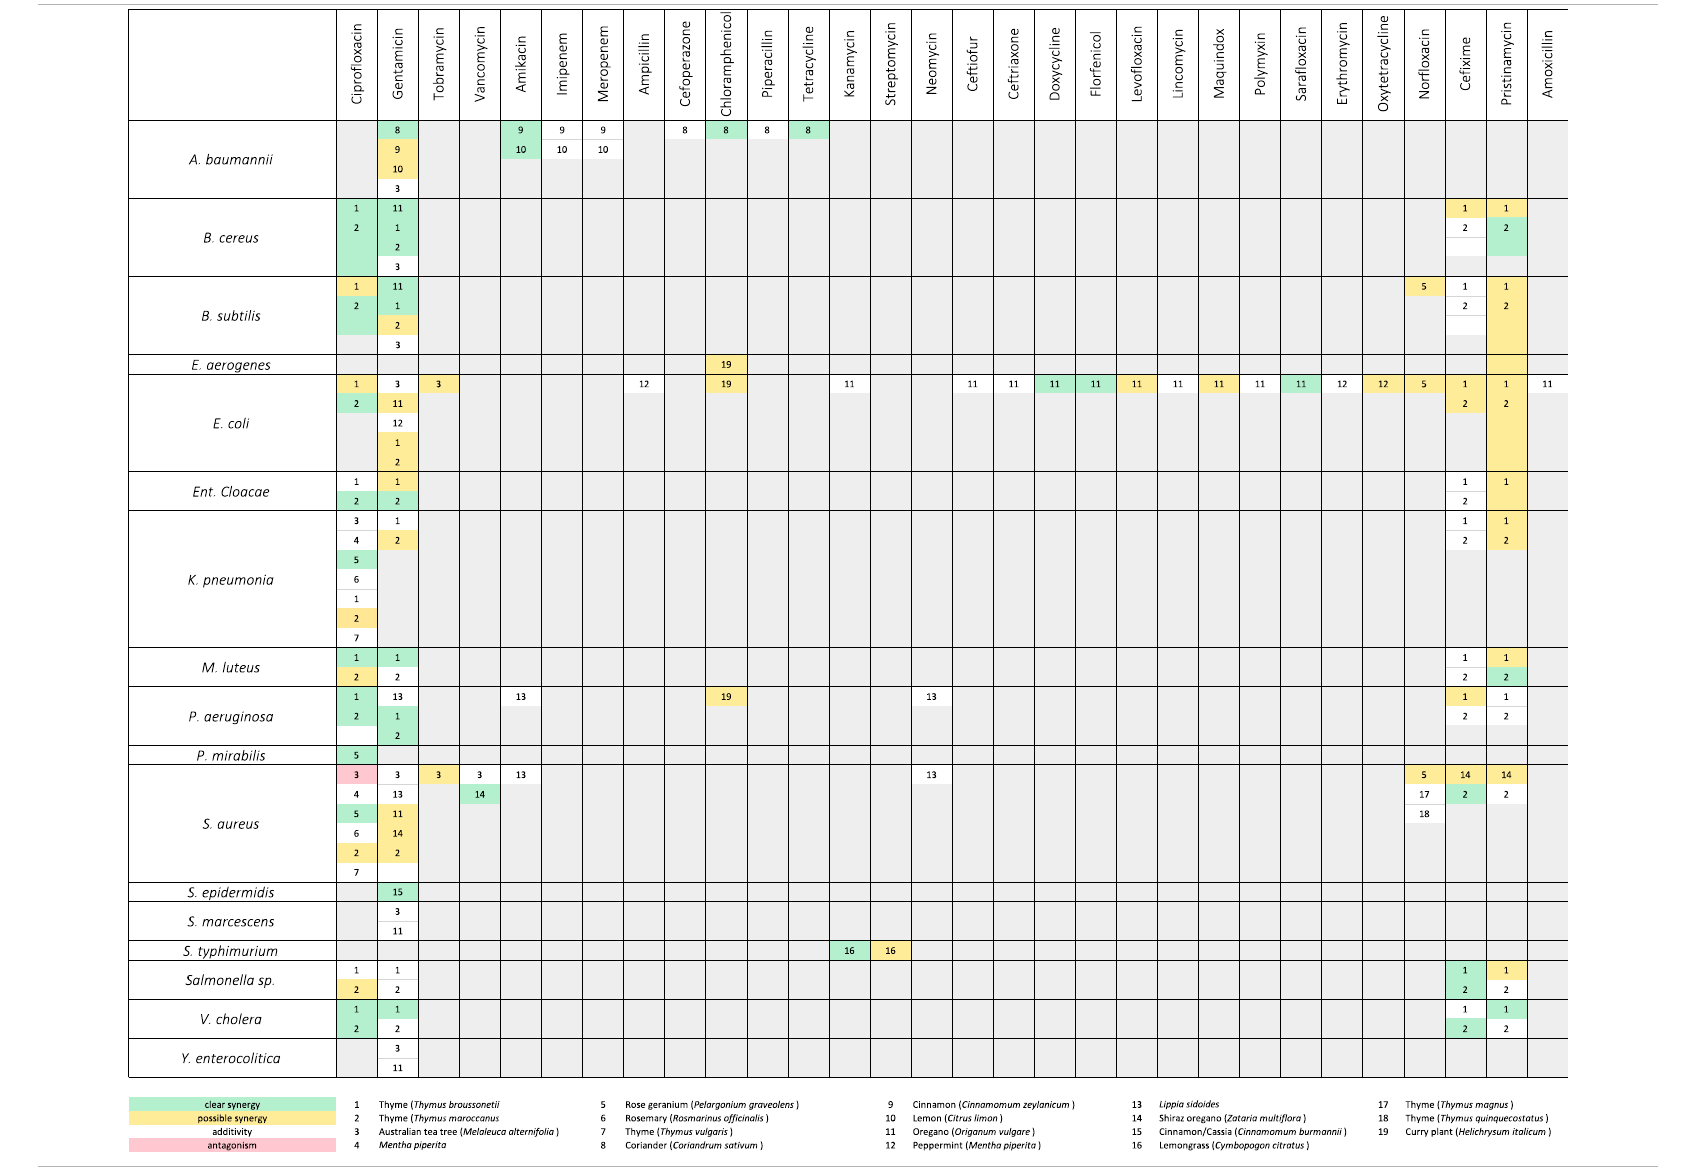
TABLE 1 | In vitro synergistic action between EOs and antibiotics. Methods used: Checkerboard assay (isobologram, fractional inhibitory concentration (FIC) index) or time-kill assay or fold reduction in minimum inhibitory concentration (MIC) or change in inhibition zone in the presence of EO vapor. [Adapted and compiled from Langeveld et al.